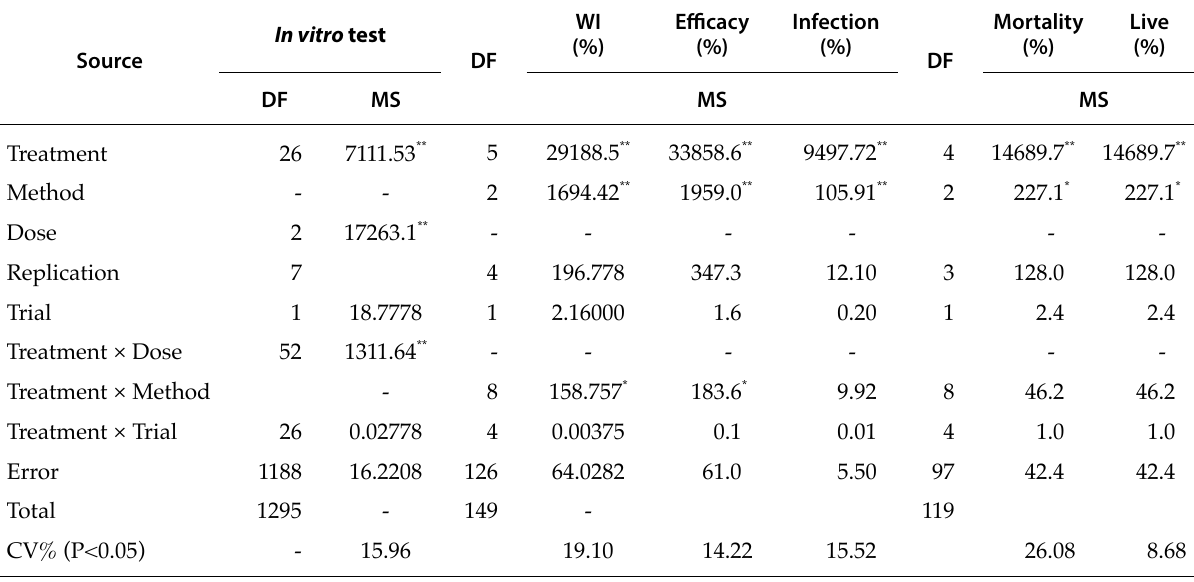
Table 2. Analyses of variance for effect of Chinese medicinal herbs on for in vitro (inhibition of mycelial growth) and green - house (WI, Efficacy, Infection, Germination, Mortality and Live Percentage) experiments.